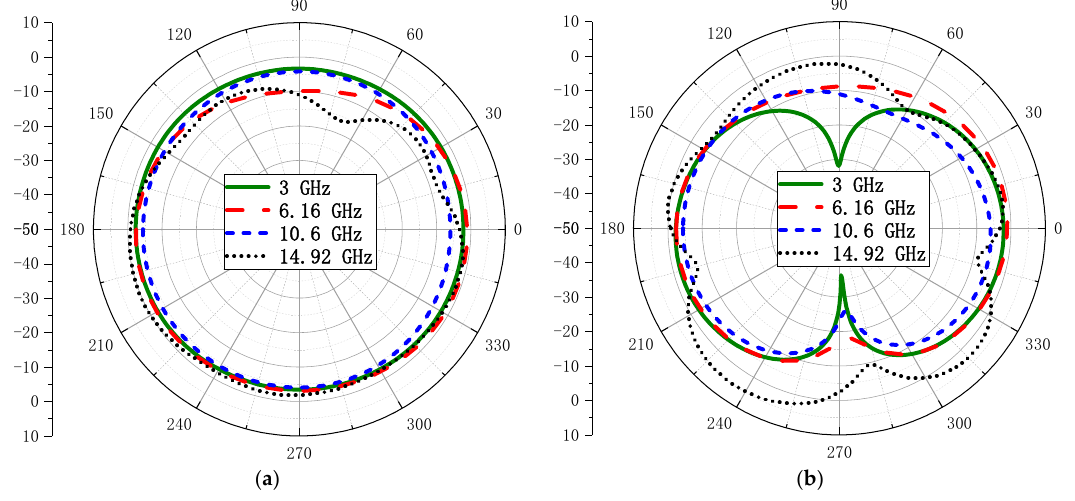
Figure 7. Simulated Radiation pattern of UWB monopole antenna in ( a ) E-plane ( φ = 0 ° ) ( b ) H-plane ( φ = 90 ° ).